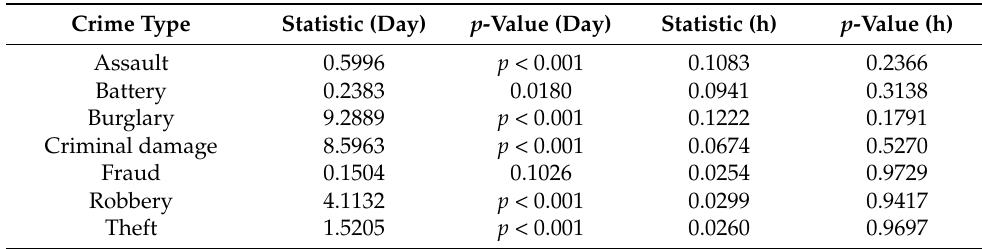
Table 2. Results of Watson’s test for different types of crimes (samples are from the temporal distribution of crimes from February to June in 2020 and